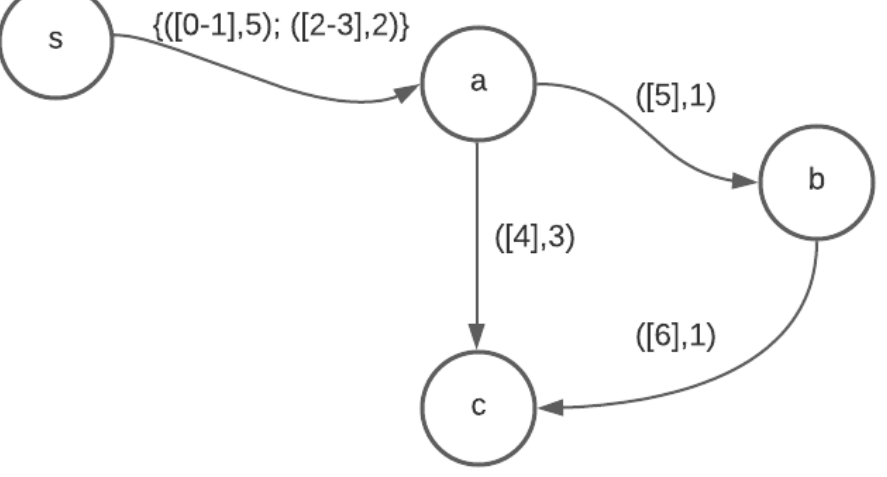
Figure 11. Interval temporal graph with some slow intervals.